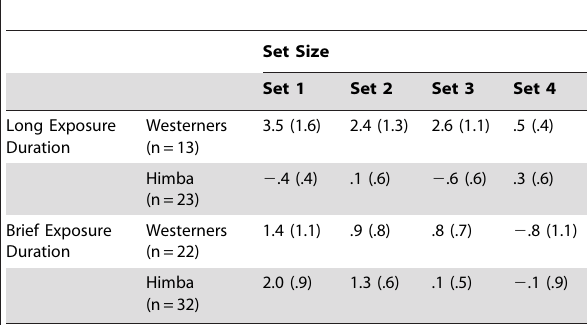
Table 1. Compatibility effects in accuracy rates (percent) as a function of set size, exposure duration, and culture; values in brackets represent standard